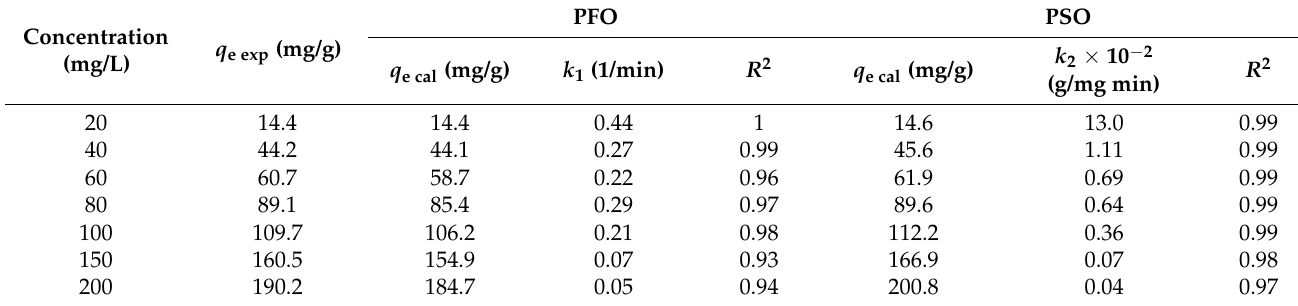
Table 6. PFO and PSO kinetic parameters for MB adsorption on MSMPAC.